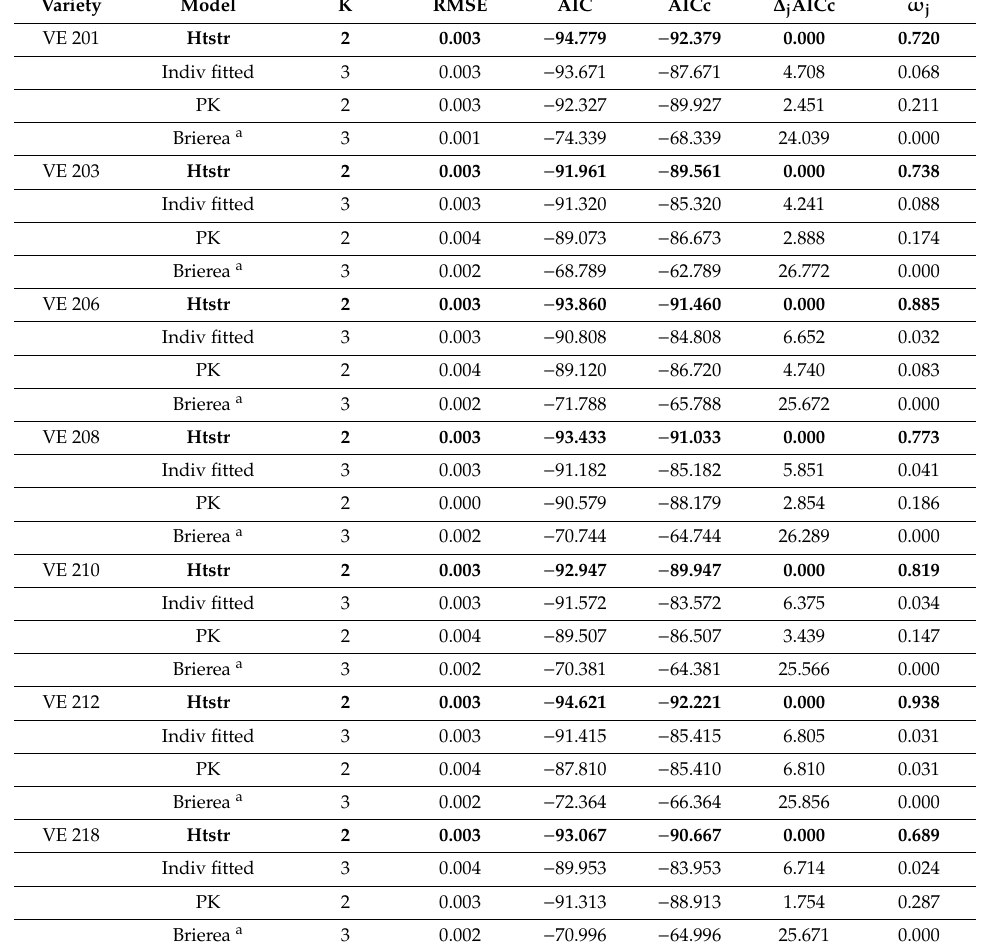
Table 2. Results with root-mean-square error (RMSE) for the published equations of Tonnang et al. [2] (Briere), with the Poikilotherm (Pk) equation [11] fit as described herein, for the heat stress equation fitted for just the first variety (Htstr), and for the heat stress fitted separately for each variety (Indiv fitted); also shown are Akaike’s Information Criterion (AIC), AICc, AICc di ff erences ( ∆ j AICc), and the derived Akaike weights ( ω j ) computed from the data. The Tbase is the x intercept for each equation that was fitted for each variety, as discussed herein. The last variety (VE 220) was not included in these analyses as discussed in this paper. K indicates the number of parameters that were used to calculate the maize development rate. The AICc-selected best model is shown here in